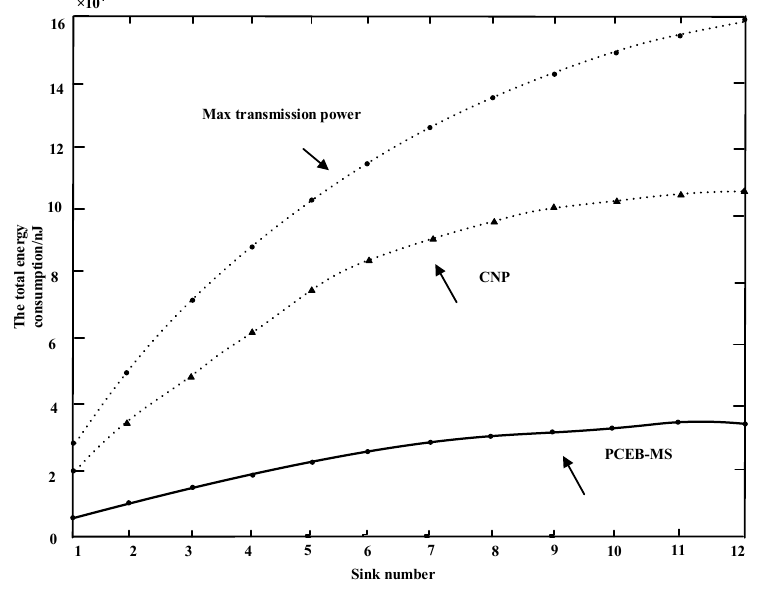
Figure 9. Comparison of total energy consumption of sinks.